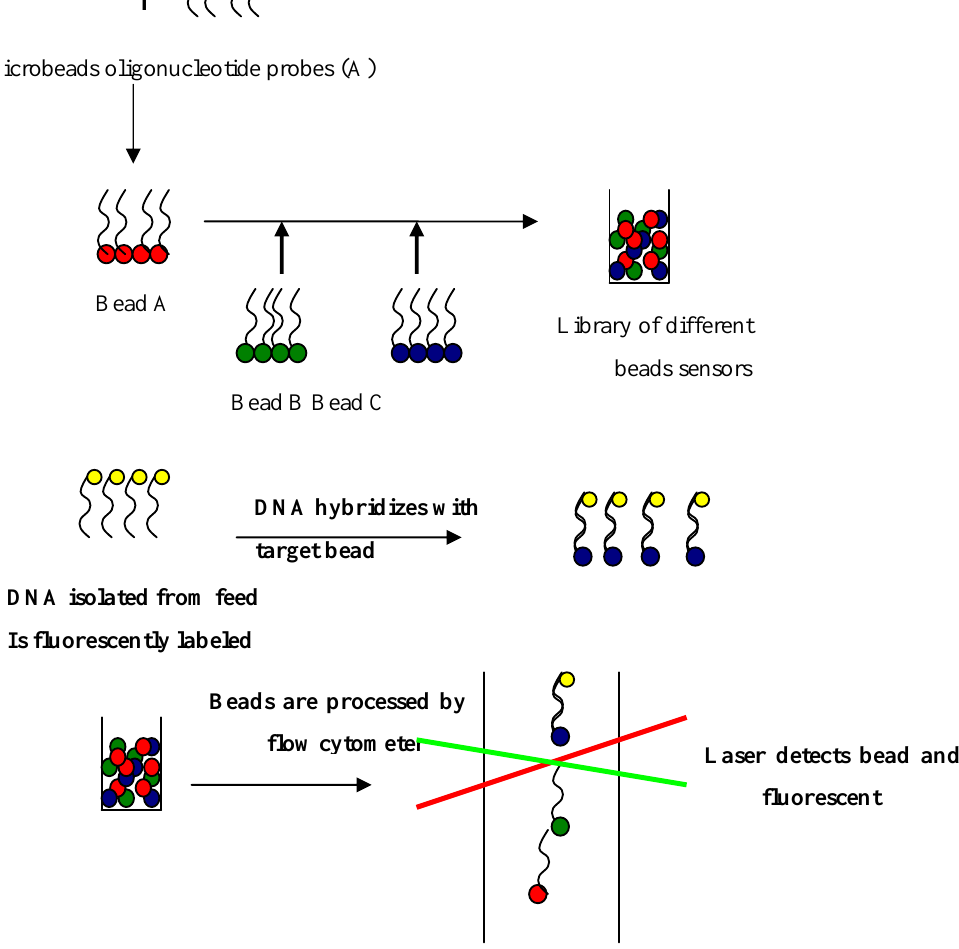
Figure 2 . Illustrated description of bead based sensor array preparation, capturing of target and analysis. A, B and C denote different oligonucleotide probes (e.g. Bead A is beads functionalized with probe A). Red, green and blue colors indicate different types of encoding